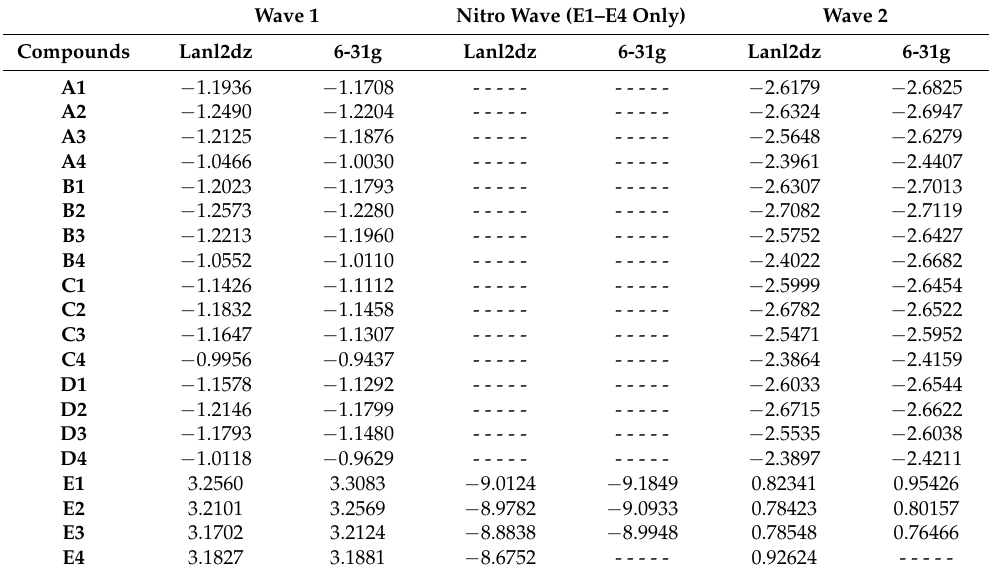
Table 4. The electrochemical cell reaction potentials ( ε ’ cell ) in volts with the ferrocene/ferrocenium reduction potential set to zero for Wave 1, Nitro Wave, and Wave 2 calculated using DFT: BYL3P with lanl2dz and 6-31g basis sets in Gaussian